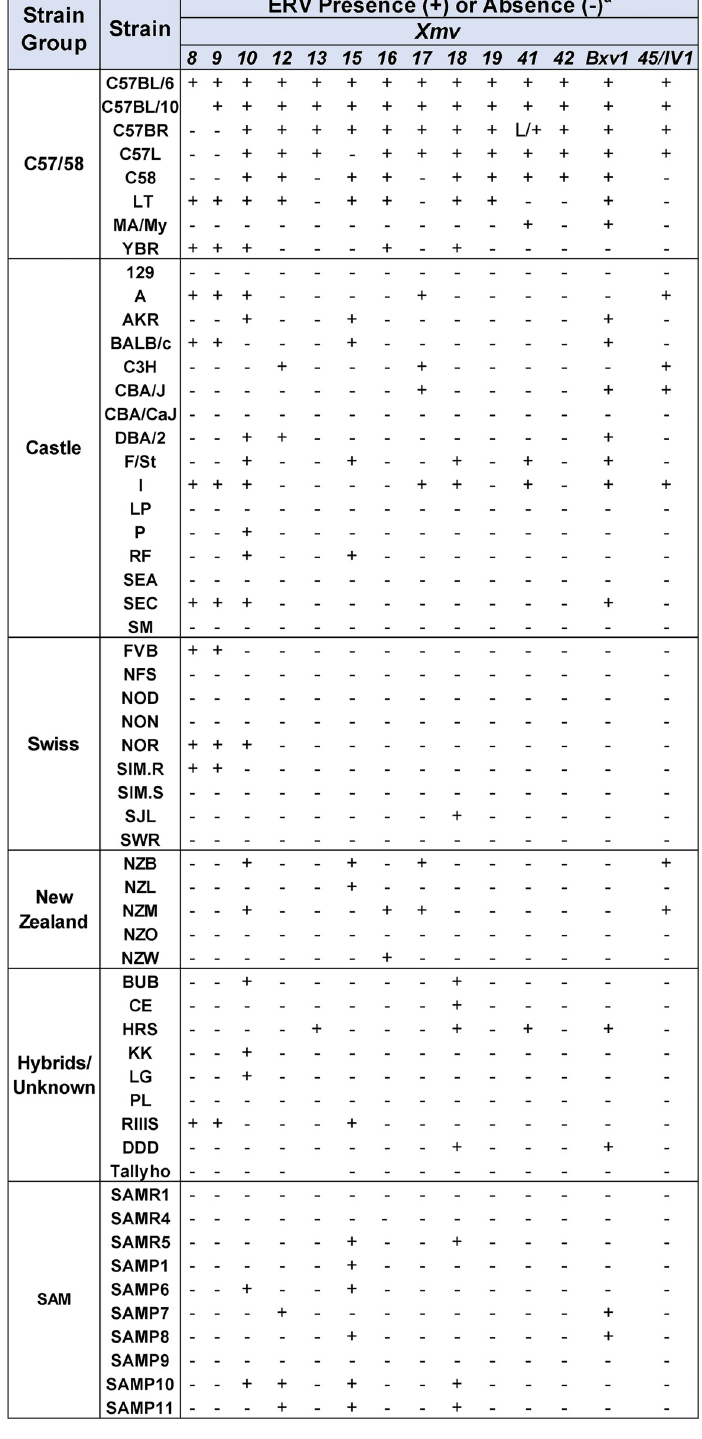
Fig 2. Classical mouse strains typed for 14 Xmvs and grouped according to known breeding history. a +, presence; -, absence; L, solo LTR.